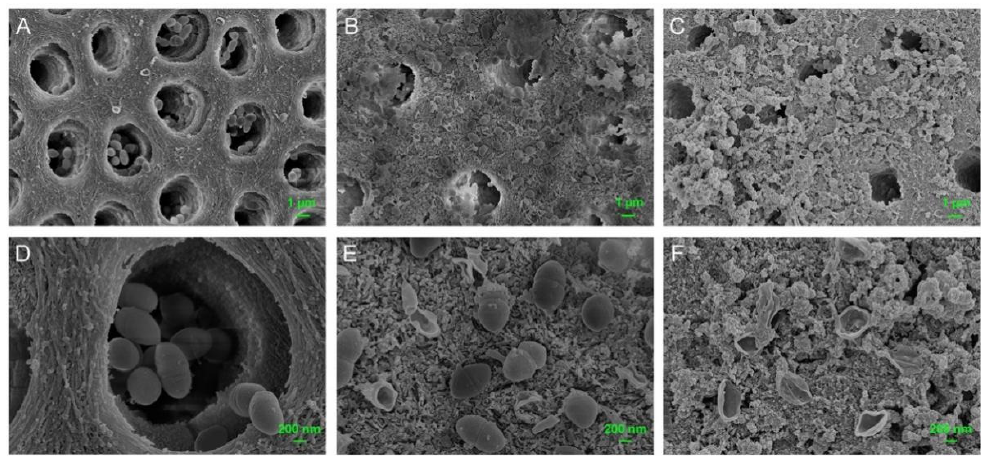
Figure 8. FE-SEM images showing anti-bacterial effects on pretreated dentin slices. ( A , D ) E. faecalis grown on dentin slice of blank control group ( A ) ×5000, ( D ) ×20,000; ( B , E ) E. faecalis grown on dentin slice of MCSNs pre-treated group ( B ) ×5000, ( E ) ×20,000; ( C , F ) E. faecalis grown on dentin slice of M-AgTX pre-treated group ( C ) ×5000, ( F ) ×20,000.